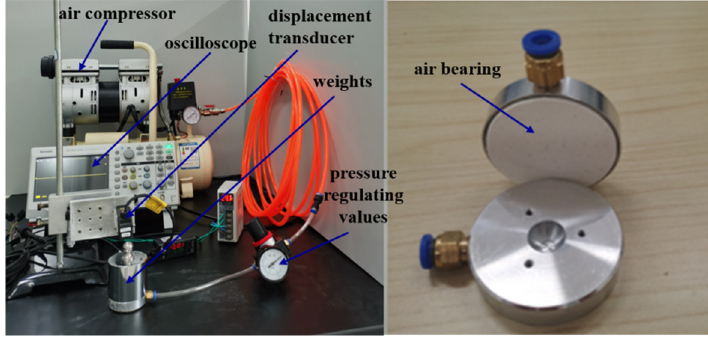
Figure 8. The static measurement system device of the air bearing.